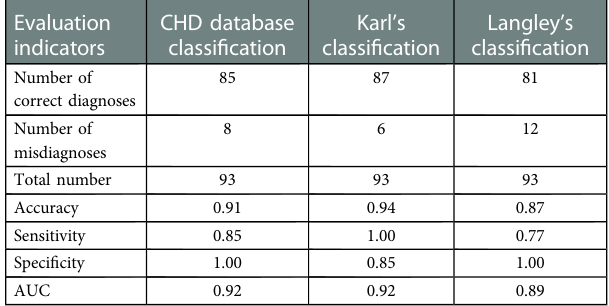
TABLE 2 Comparison of diagnostic criteria based on manual measurement. Evaluation indicators